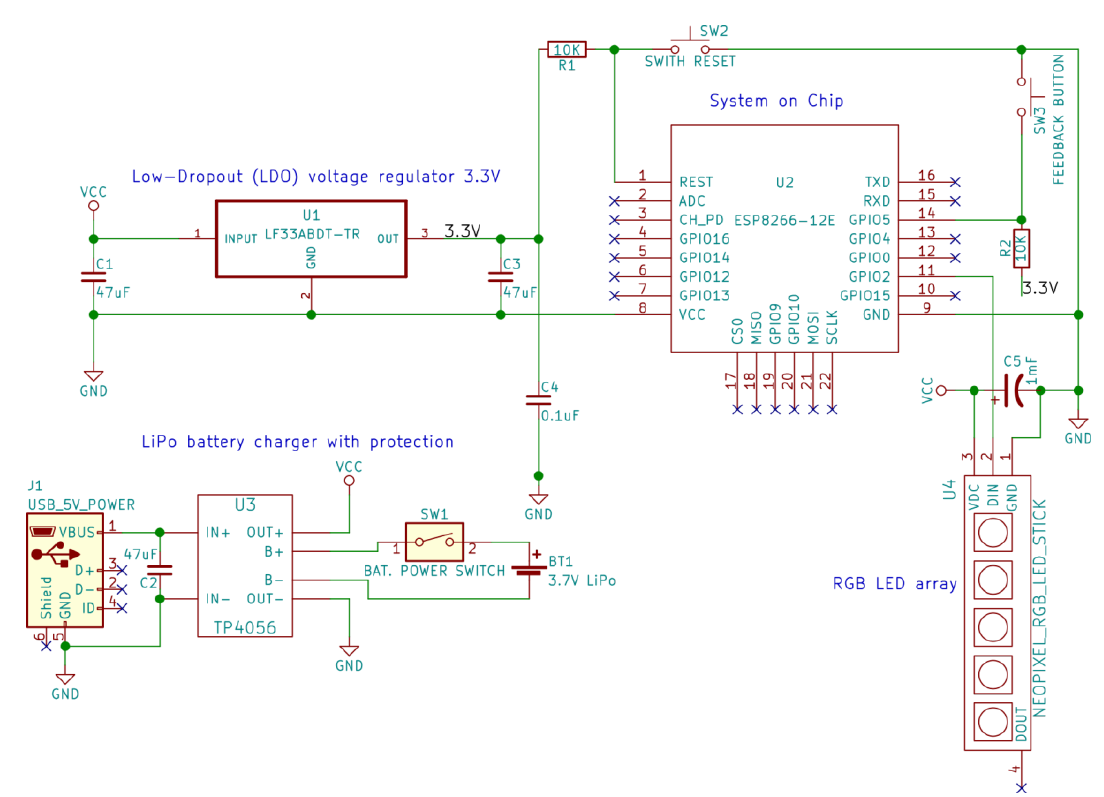
Figure A2. Hardware scheme of the smart device for promoting physical activity.